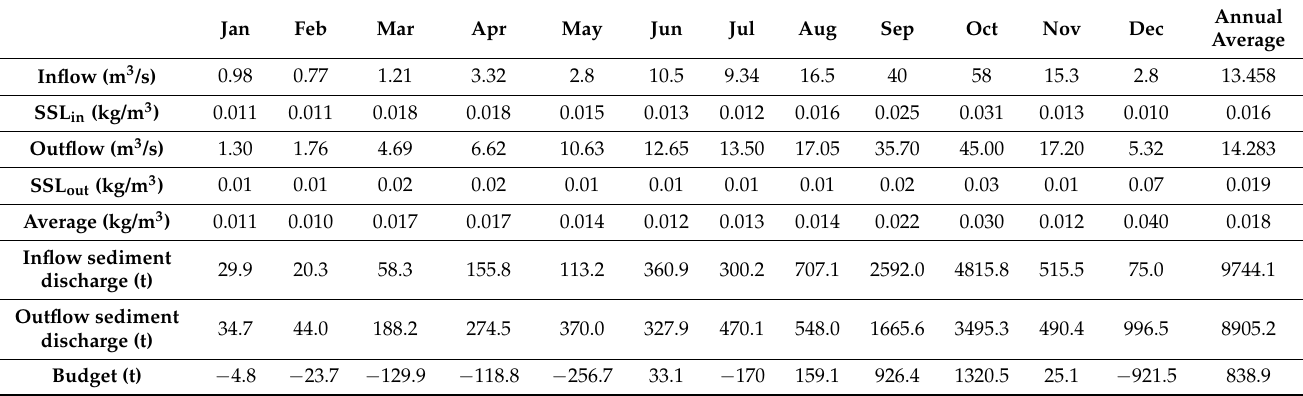
Table 2. Suspended sediment discharge balance for the Lobo River